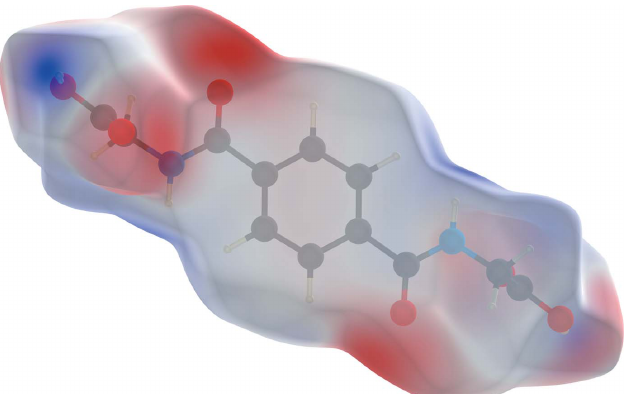
Figure 10 View of the transparent three-dimensional Hirshfeld surface of the N , N 0 - (1,4-phenylenedicarbonyl)diglycine solvent molecule plotted over elec- trostatic potential energy in the range (cid:4) 0.0828 to 0.1815 a.u. using the STO-3G basis set at the Hartree–Fock level. The O—H (cid:2)(cid:2)(cid:2) O, N—H (cid:2)(cid:2)(cid:2) O and C—H (cid:2)(cid:2)(cid:2) O hydrogen-bond donor and acceptor atoms are displayed as blue and red regions around the atoms corresponding to positive and negative potentials, respectively.